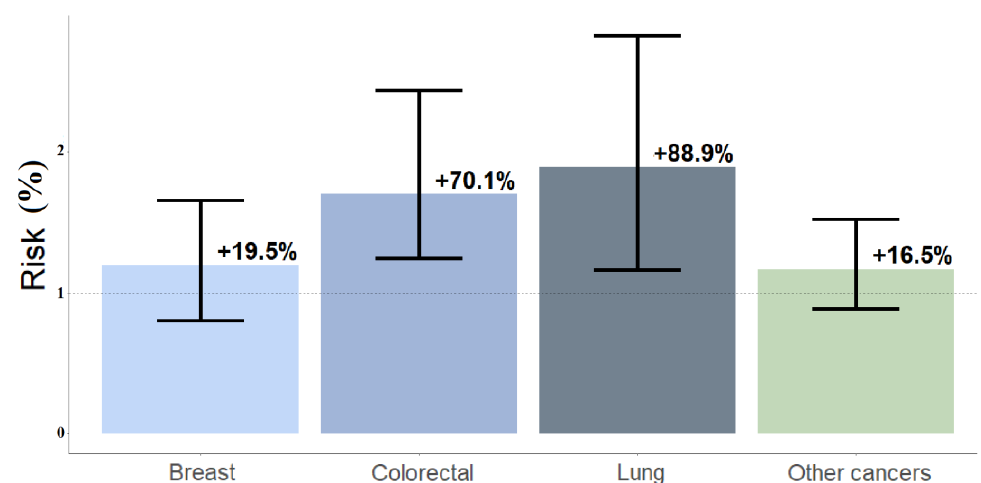
Figure 7. Simulation 4 refers to simulated odds ratios (SORs); percentages are labeled. This was performed for younger vs. older patients with bone metastases. Young patients had a significantly higher risk to receive multiple remote consultations for lung cancer. SORs were 1.89, 95%CI = 1.16, 2.82 for lung cancer and 1.70, 95%CI = 1.24, 2.43 for colorectal cancer. No statistical significance was found for other cancers (SOR = 1.16, 95%CI = 0.91, 1.52) and breast cancer (SOR = 1.19, 95%CI = 0.80,